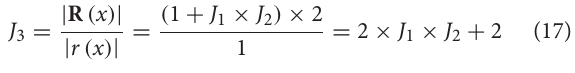
Algorithm 1 recaps the pseudocode of the 18-way DA method.